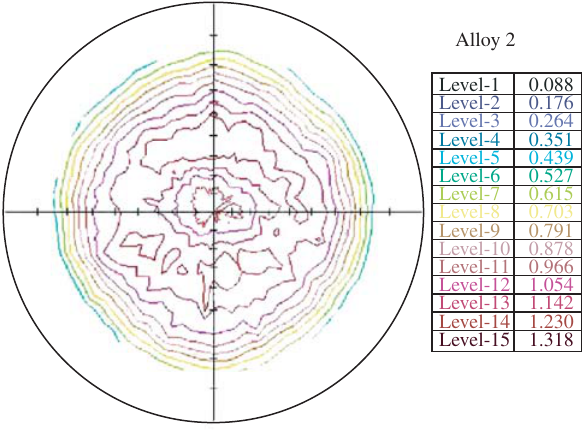
Figure 7. Pole figure obtained from alloy 2, whose specimen was taken from a cylinder liner. This pole figure shows that the specimen has no texture.